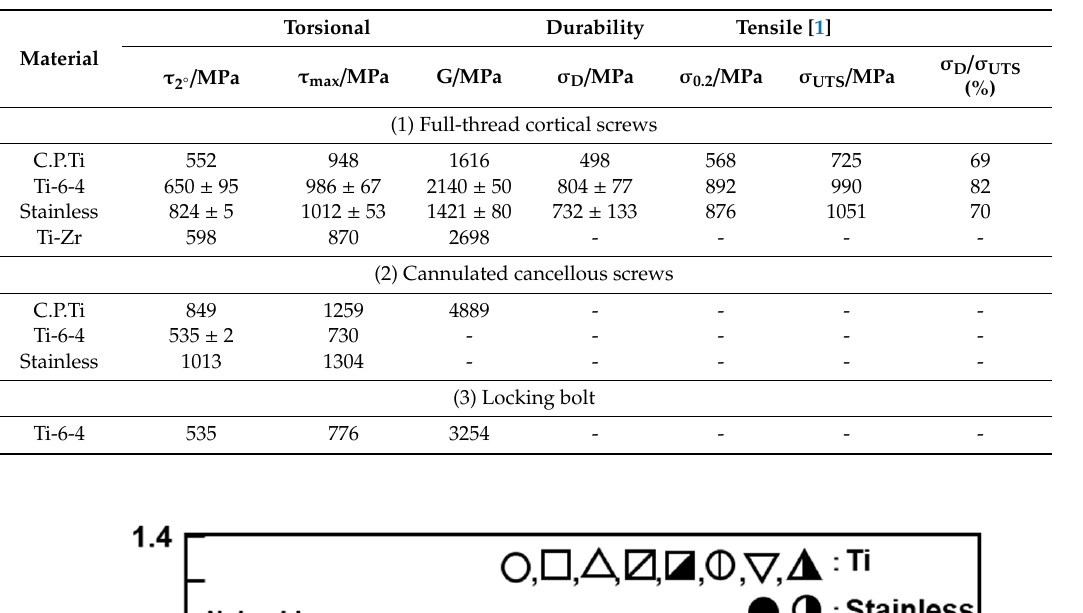
Table 3. Mechanical properties obtained by torsional breaking and four ‐ point bending durability tests with various screws.